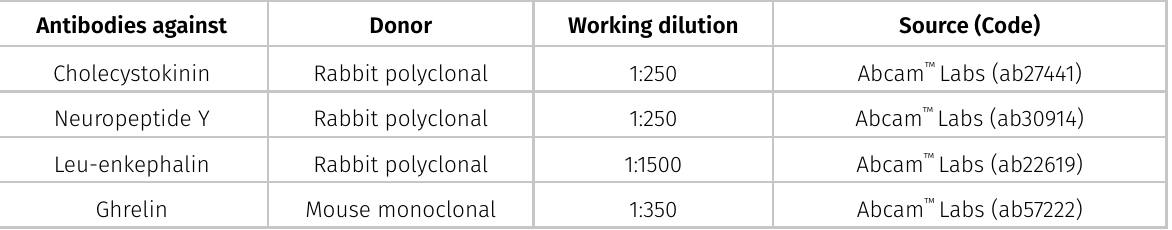
Table I. List of primary antisera used in this study. Antibodies against Donor Working dilution